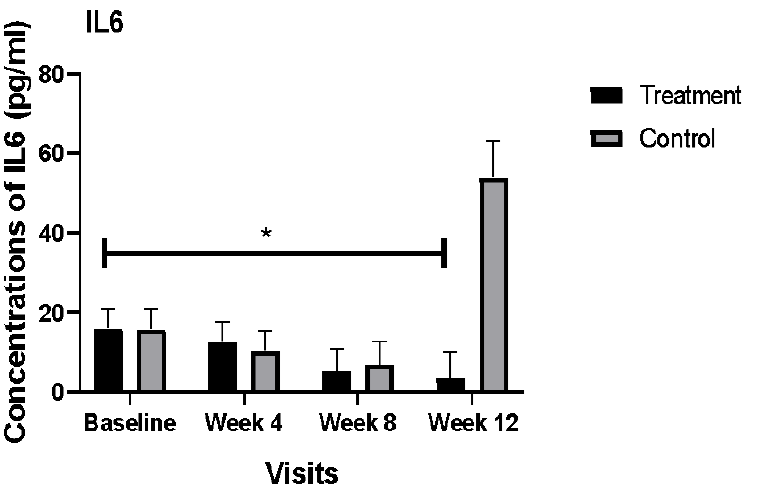
Figure 1. Comparison of mean plasma concentrations of IL6 (pg/mL) between the treatment and control group during the 12 weeks of the study. Bars represent the means ± SEM. * Denotes a significant time by group interaction ( p <